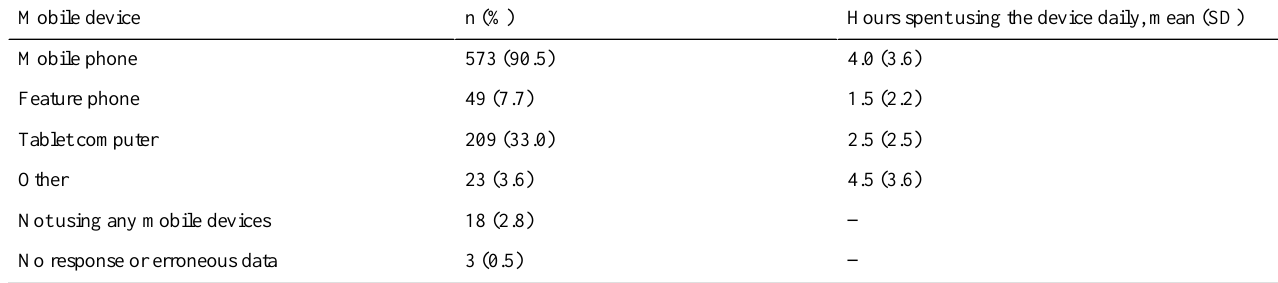
Table 2. Prevalence and extent of mobile device use